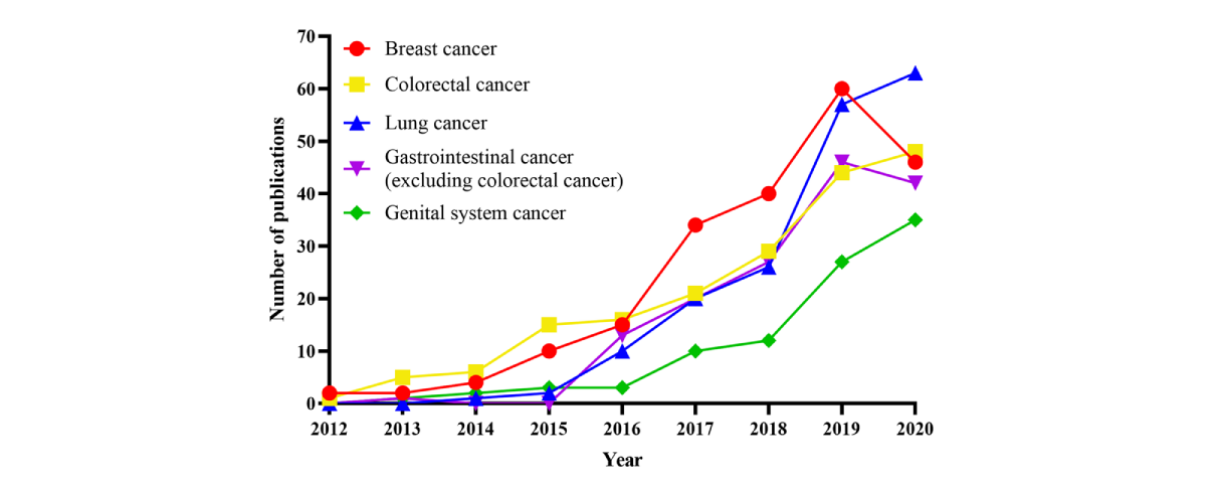
Figure 3. The trends in publications on the top 5 cancer sites in mainland China from the Surveillance, Epidemiology, and End Results database